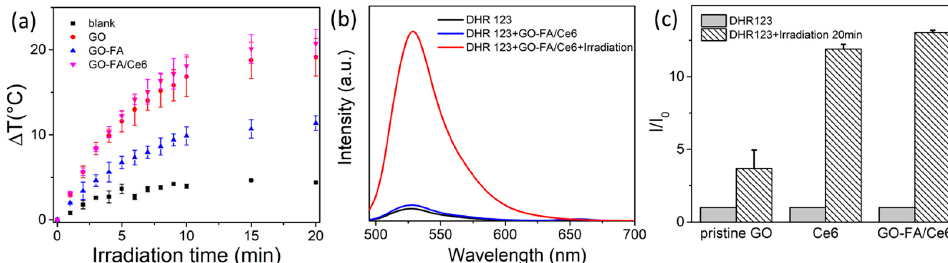
Figure 3. ( a ) Temperature increases in aqueous dispersions of GO, GO–FA and GO–FA/Ce6 at different time points under 808 nm irradiation, ( b ) DHR123 test for ROS generation by GO–FA/Ce6 under 660 nm irradiation and ( c ) normalized DHR123 fluorescence for ROS generation by GO, Ce6 and GO–FA/Ce6.